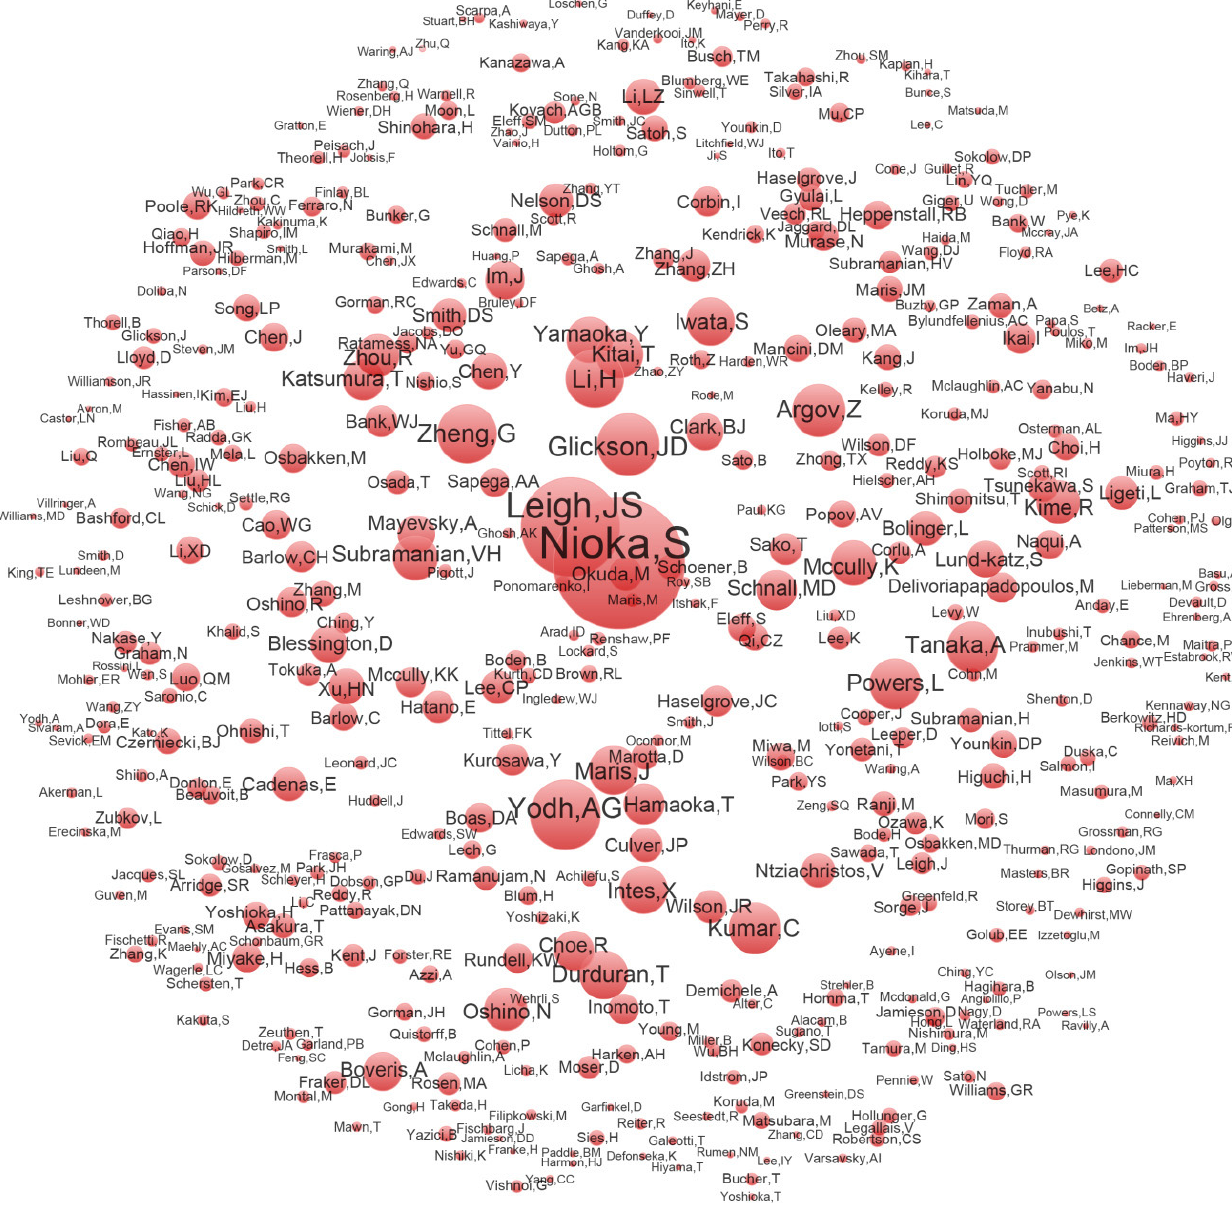
Fig. 7. Coauthor maps. All coauthors with more than 1 publication with Britton Chance. The size of sphere is proportional to the number of